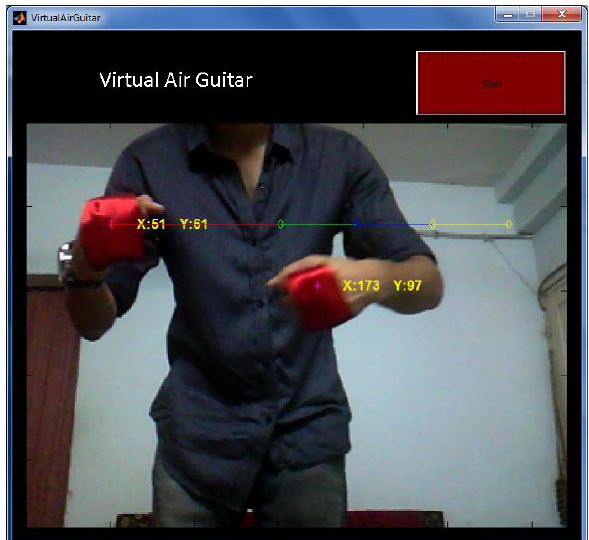
Figure 2 . Project Output